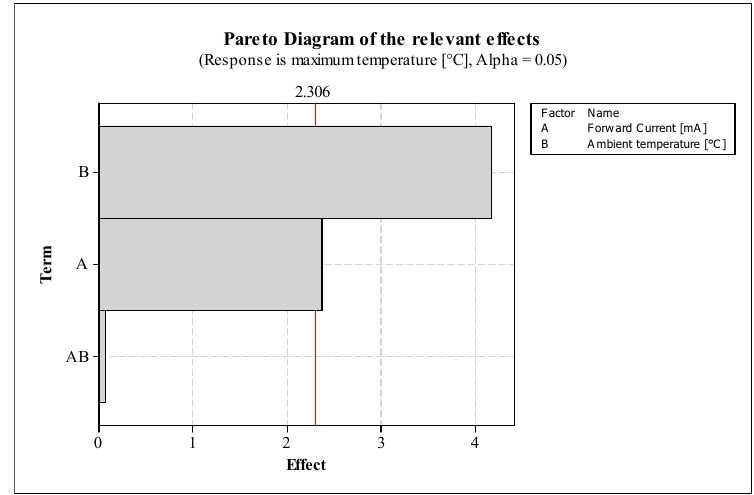
Figure 16. Pareto diagram of the effects with maximum temperature as response.